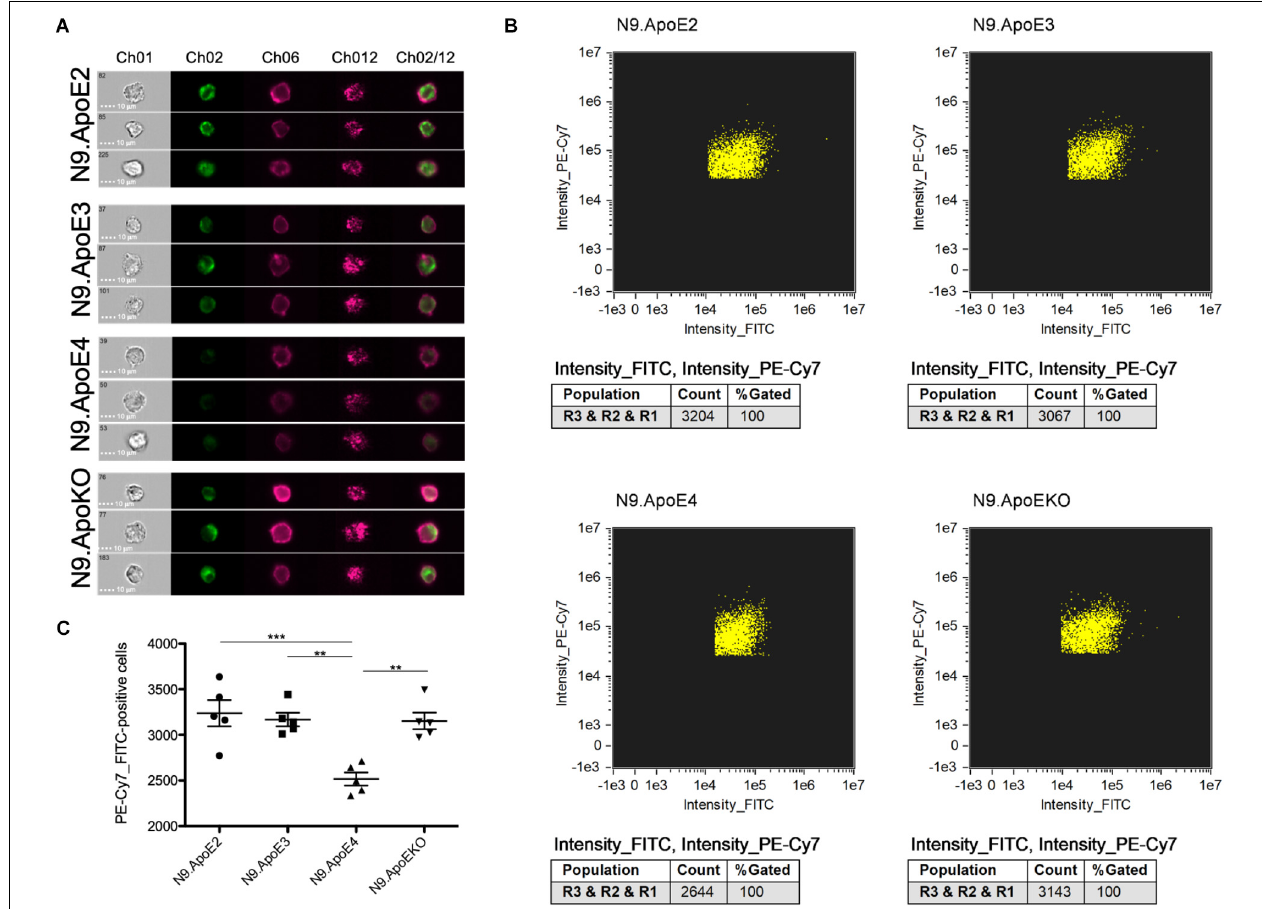
FIGURE 6 | Microglia phagocytosis of aged/oligomerized A β 42 is decreased in N9.ApoE4 cells. (A) Representative pictures of imaging flow cytometry of N9 microglia-cells (purple) after phagocytosis of aged/oligomerized FITC-labeled A β 42 (green). Ch01: brightfield; Ch02: FITC (aged/oligomerized A β 42 ); Ch06: PE-Cy7-anti-CD11b (N9 microglia-cells); Ch12: side scatter; Ch02/12: overlay of Ch02 and Ch06. The images demonstrate the significantly decreased phagocytosis by N9.ApoE4 in comparison to the other cell lines [a total of 75.000 cells was analyzed in n = 5 (including each three technical replicates of 5000 cells)]. (B) Gating of FITC + PE-Cy7 + N9 cells was done with AMARIS software. (C) 5.000 N9 cells of each group were quantified with AMARIS and Prism software. Statistical significance was set up at ∗∗ p < 0.01 and ∗∗∗ p <